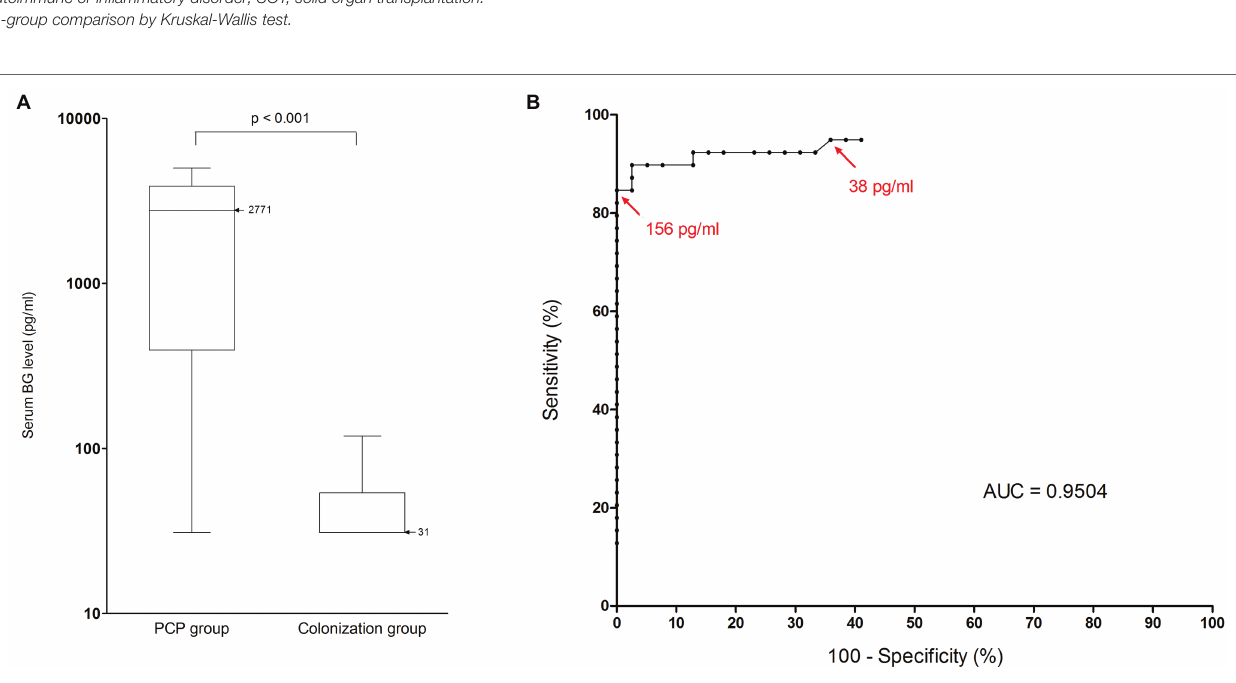
FIGURE 1 | Performance of BG assay for Pneumocystis pneumonia diagnosis in HIV-negative population. (A) Serum BG levels (pg/ml) in patients with Pneumocystis pneumonia and in colonized patients. Black horizontal bars, median values. The median value for PCP patients was 2,771 pg/ml (range, 31–5,000; interquartile range, 3,490 pg/ml). The median value for colonized patients was 31 pg/ml (range, 31–119; interquartile range, 23 pg/ml). Serum BG levels were significantly lower in the colonization group than in the PCP group (Mann–Whitney test, p < 0.001). (B) Receiver operating characteristic curve for serum BG assay performance, using microscopic detection of Pneumocystis jirovecii as the reference method. Red arrows represent calculated thresholds for maximal specificity (156 pg/ml) and maximal sensitivity (38 pg/ml). AUC, area under the curve; BG, (1,3)- β -D-glucan; and PCP, Pneumocystis pneumonia.